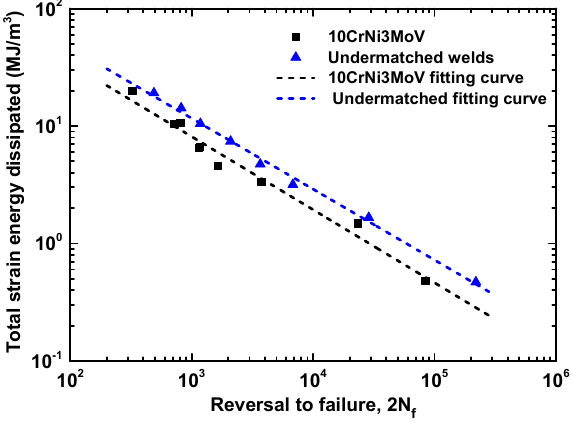
Figure 12. Comparison of Plastic strain energy density ∆ W p from different equations: ( a ) 10CrNi3MoV high strength steel; ( b ) undermatched welds.